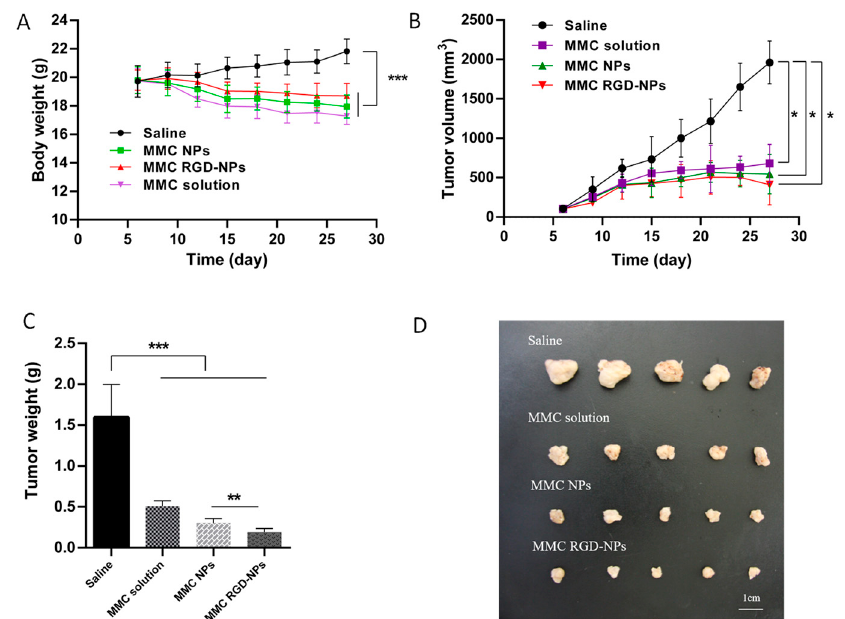
Figure 12. Studies of antitumor efficacy of MMC RGD-NPs in vivo. ( A ) Body weight of mice treated with saline, MMC solution, MMC NPs, MMC RGD-NPs (mean ± SD, n = 5). ( B ) Tumor volume of mice treated with saline, MMC solution, MMC NPs, MMC RGD-NPs (mean ± SD, n = 5). ( C ) Weight of isolated tumors in groups of saline solution, MMC solution, MMC NPs, MMC RGD-NPs (mean ± SD, n = 5). ( D ) Isolated tumor tissues of mice treated with saline, MMC solution, MMC-NPs, MMC-RGD-NPs (mean ± SD, n = 5), * p < 0.05, ** p < 0.01, and *** p < 0.001 to control.